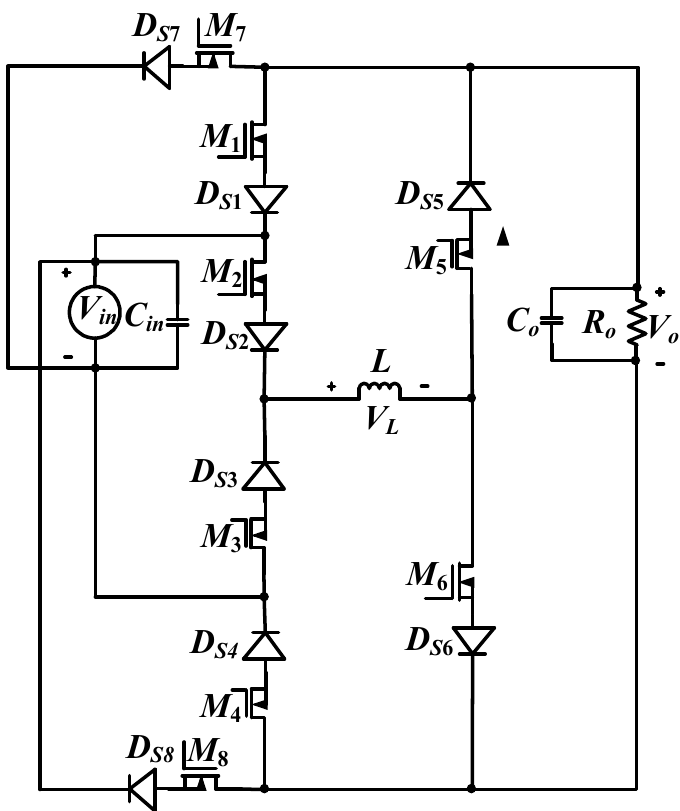
Figure 1. Buck-boost voltage controller reported in [20].